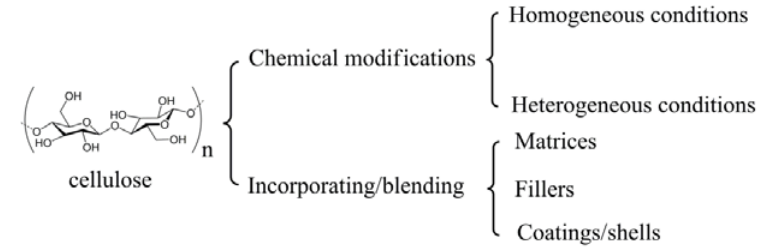
Figure 3. Preparation strategies of “smart” materials based on